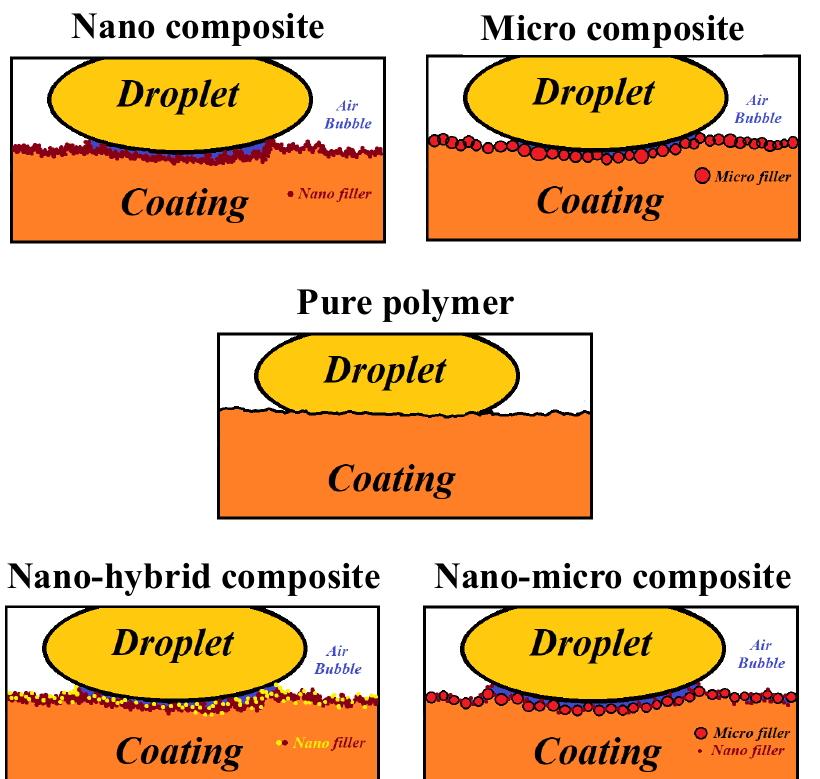
Figure 6. Schematic of the proposed the effect of adding nano- and microfillers on the ups and downs of the surface, increasing surface roughness, water drop shape on the coating (wettability), contact angle, and